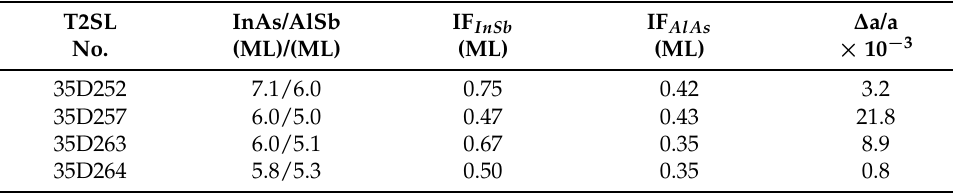
Table 1. N umerical calculation of the HRXRD